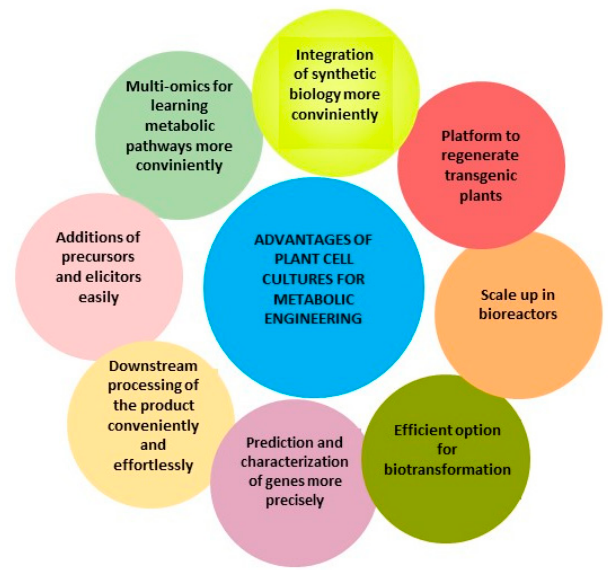
Figure 2. Advantages of plant cell cultures for metabolic engineering.